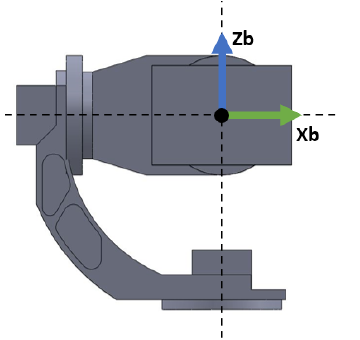
Figure 3. Base reference frame fixed to the three-axis gimbal base.